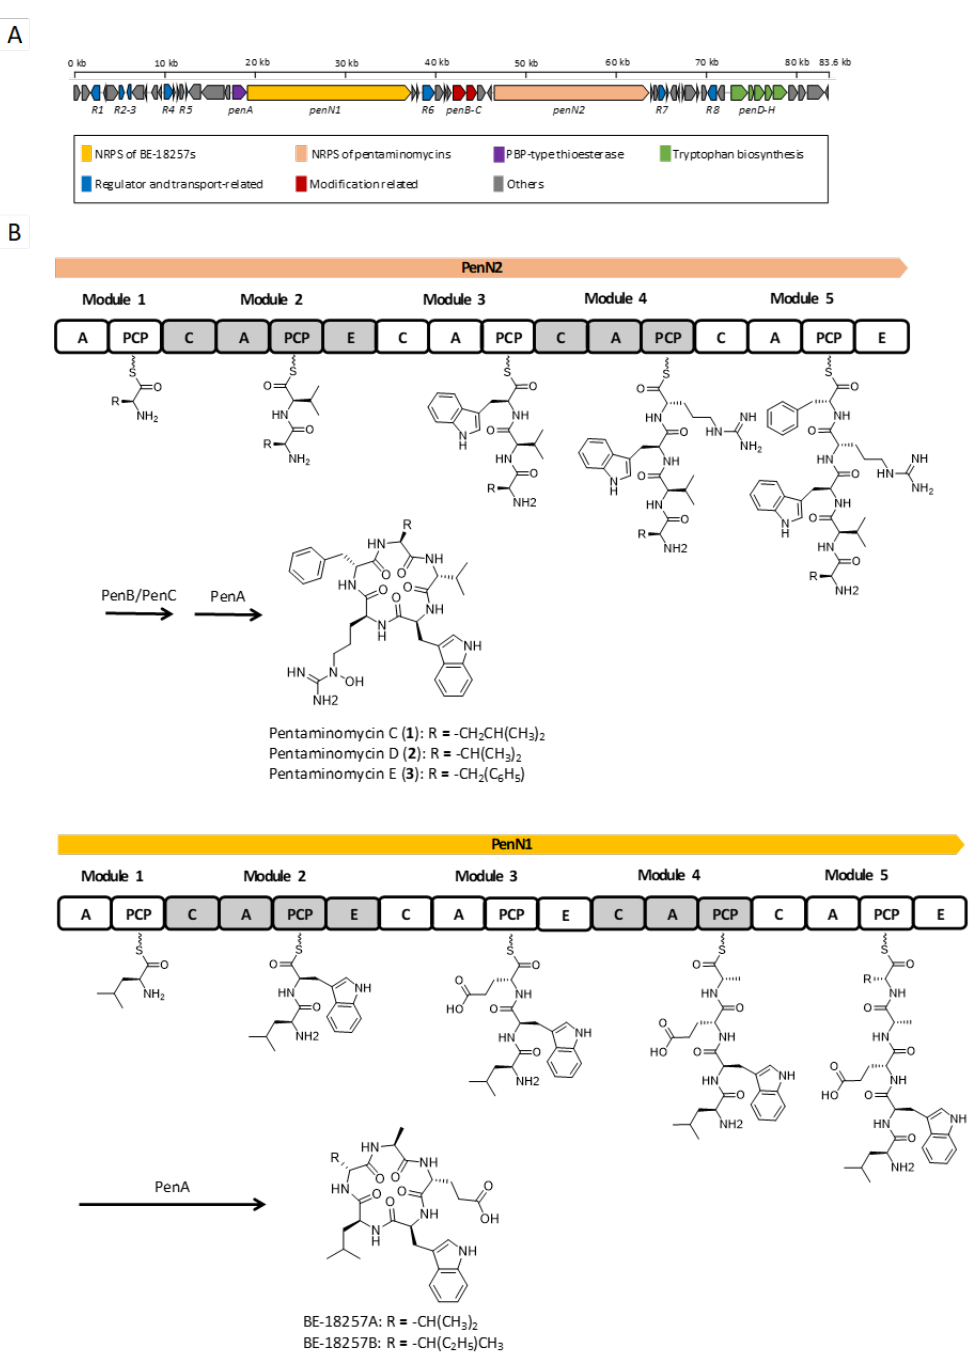
Figure 3. Proposed biosynthesis pathway for the BE-18257s and the pentaminomycins. ( A ) Genetic organization of putative biosynthetic gene cluster of the pentaminomycins. ( B ) Putative biosynthetic pathway for the pentaminomycins and the BE-18257s with the nonribosomal peptide synthetase (NRPS) modular organization. C, condensation domain; A, adenylation domain; PCP, peptidyl carrier protein; E, epimerase domain.